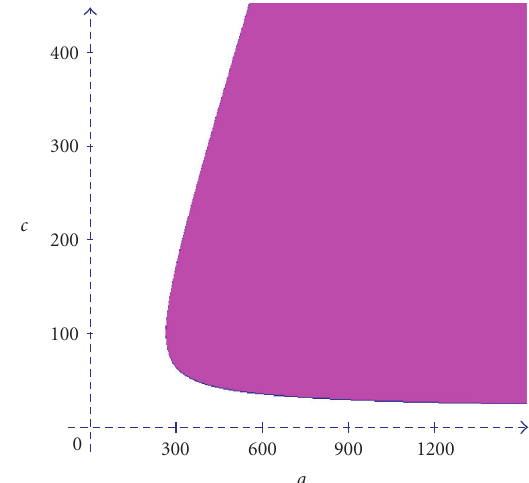
Figure 4.2 . Region of necessary and su ffi cient stability condition for (3.4): p = 100, h = 0.